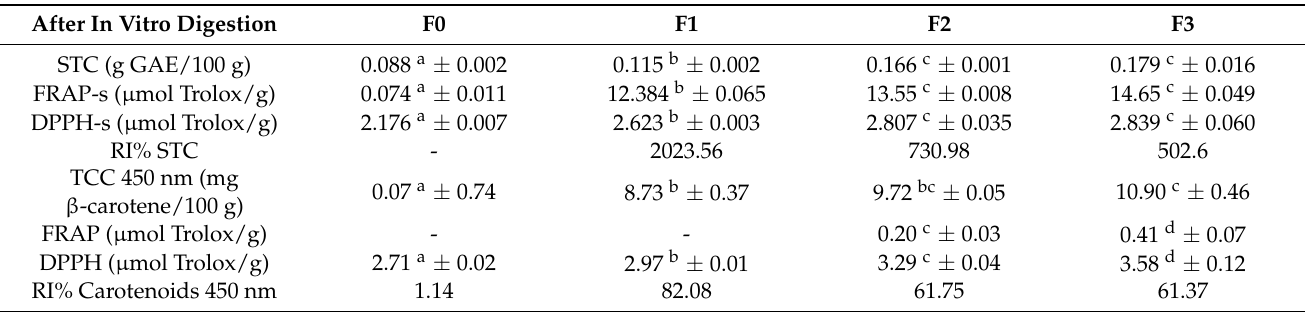
Table 7. Soluble tannin content (STC), antioxidant activity of the soluble fraction (FRAP-s and DPPH-s) and of the carotenoids fraction (FRAP-c and DPPH-c) after in vitro digestion, and RI% of STC and carotenoids of the